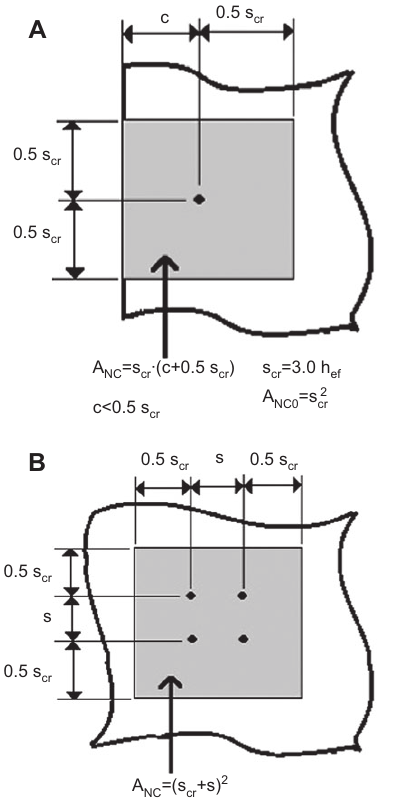
Figure 3 Calculation of effective areas. (A) Single anchor located near a concrete edge. (B) Anchor group away from